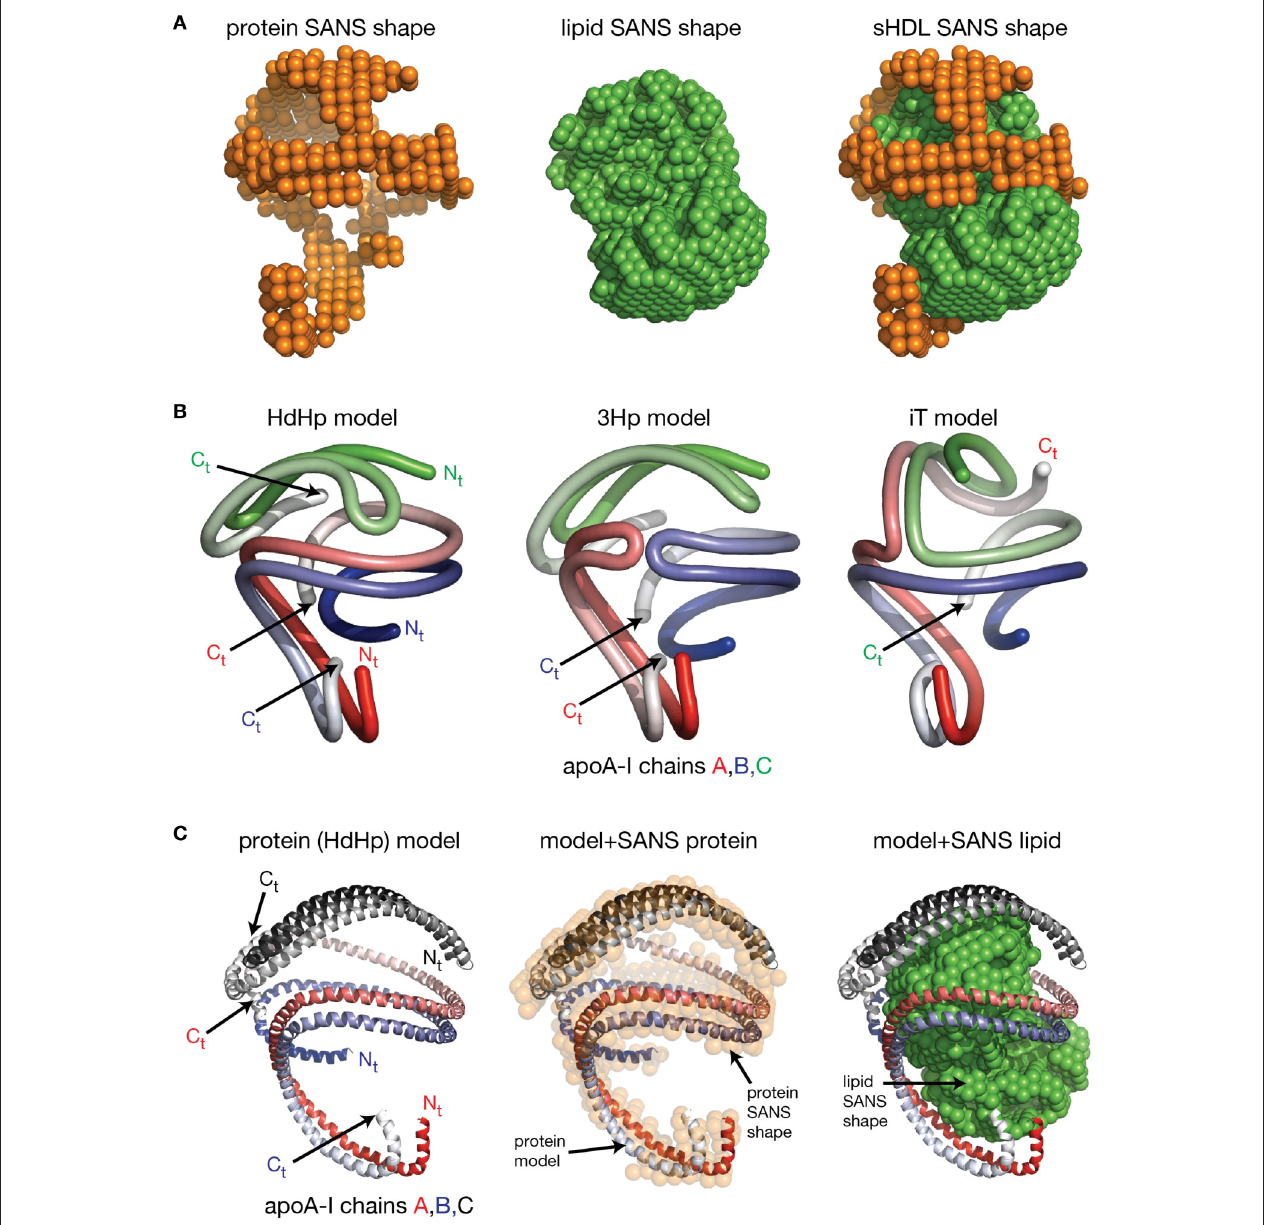
FIGURE 8 | The low resolution structure and models of sHDL. (A) Left: The low resolution structure of the protein component of sHDL obtained from SANS with contrast variation. Middle: The low resolution structure of the lipid component of sHDL. Right: The low resolution structure of sHDL as a composite of the low resolution structures of the protein and lipid components of sHDL. (B) Schematic representation of the three apoA-I chains in three hypothetical models of sHDL proposed by Wu et al. (2011): HdHp, 3Hp, and iT. Tubes colored with gradient red, blue and green are used to represent the protein chains. Left: The HdHp model of sHDL. Middle: The 3Hp model of sHDL; the locations of C t of chains A and B are interchanged with respect to the HdHp model. Right: The iT model of sHDL; the locations of C t of chains A and C are interchanged with respect to the HdHp model. (C) Left: The HdHp model of the apoA-I trimer in sHDL. The apoA-I chains shown in cartoon representation are colored with gradient red/blue/gray. The chains in the AB dimer are oriented antiparallel in helix 5 registry. The chain C is folded into a hairpin and interacts for the AB dimer in specific regions of apoA-I. Right: Superposition of the protein model (HdHp) and the lipid low resolution structure. The authors have not proposed a model for the lipid component of sHDL.